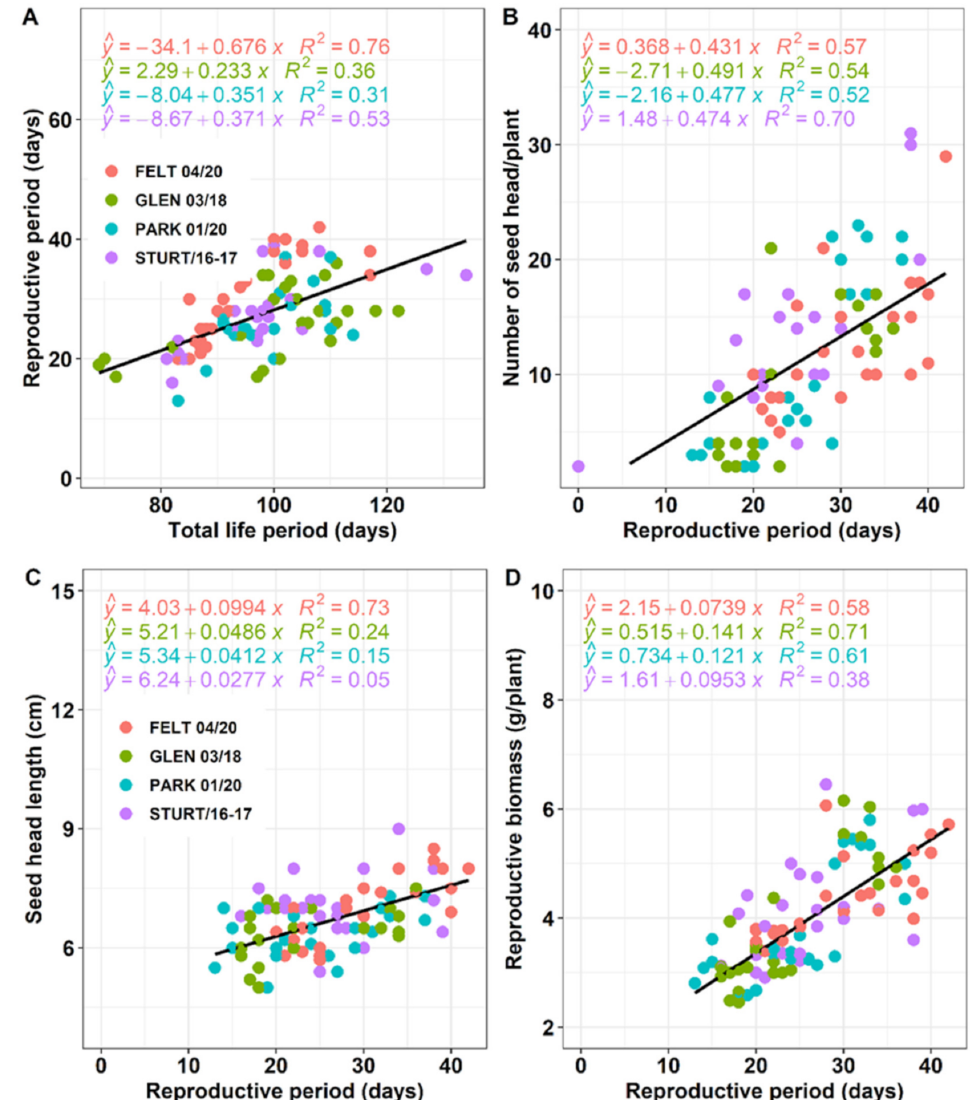
Figure 4. Reproductive period ( A ) and number of seed heads/plant ( B ) of feathertop Rhodes grass in relation to the total life period and reproductive period, respectively. Seed head length ( C ) and reproductive biomass ( D ) of feathertop Rhodes grass in relation to reproductive period. There were significant ( p < 0.05) differences in slopes between populations. R 2 represents the co-efficient of